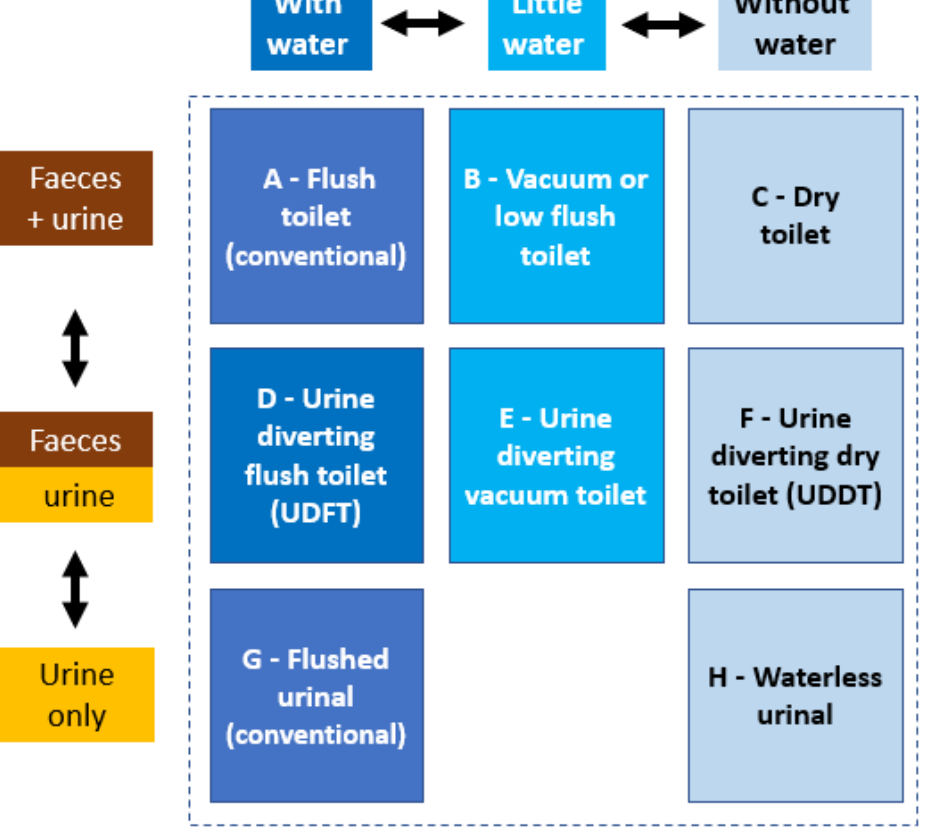
Figure 4. Toilets and urinals, categorized by water use and urine diversion. Grey: currently used toilet and urinal types.